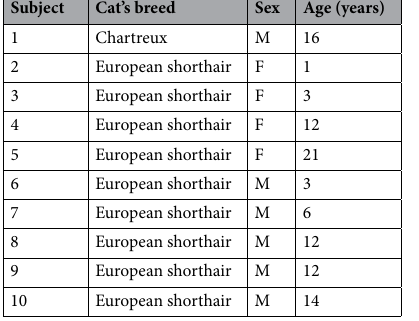
Table 2. Cats study population by race, sex (F: Female, M: Male) and